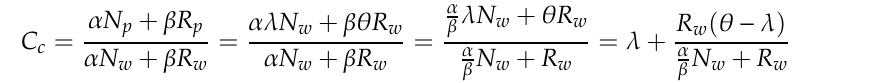
Figure 5. Images of ( a ) true-color RGB, ( b ) Ncam lp, and ( c ) Ncam tp; and ( d ) Preprocessed RGB values of true-color RGB and Ncams